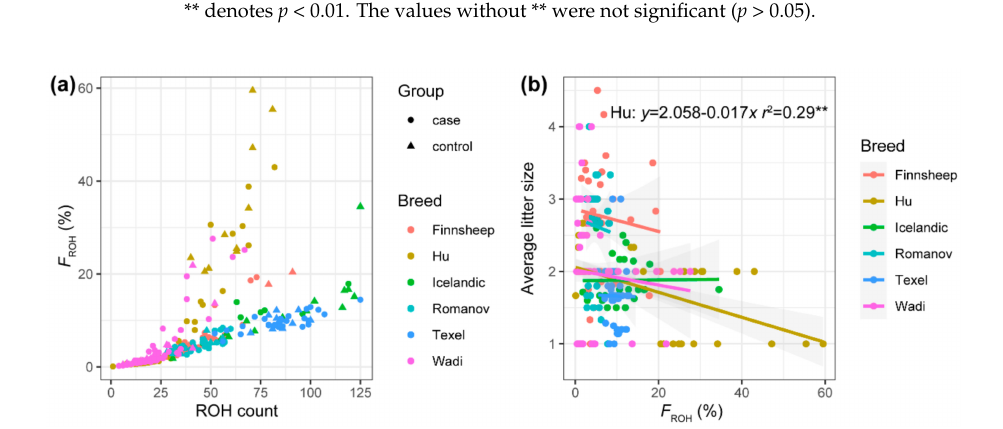
Figure 1. Inbreeding levels of six sheep breeds. Scatter plots of F ROH against the number of runs of homozygosity (ROH) ( a ), and average litter size against F ROH ( b ). ** denotes p -value < 0.01. The regression for Hu sheep is shown because it is the only breed with significant